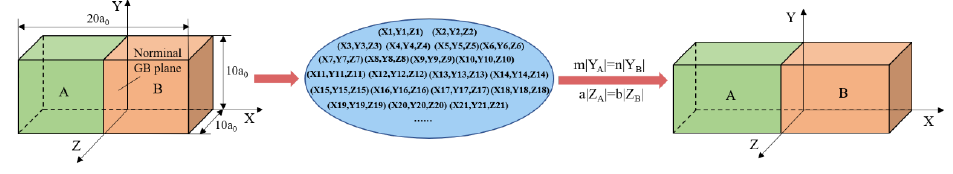
Figure 1. The grain boundary (GB) models generation process.